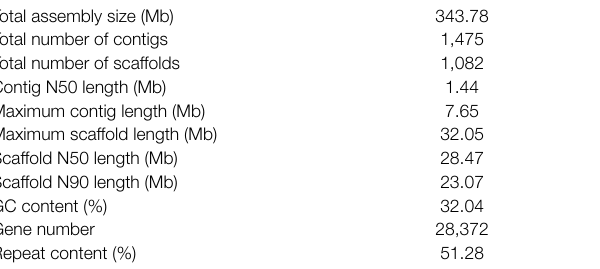
TABLE 1 | Statistics of the A. edgeworthii genome assembly. Total assembly size